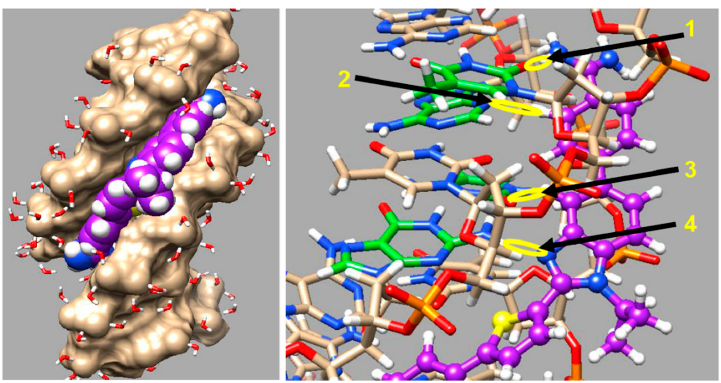
Figure 8. Molecular Dynamics (MD) model of DB2708 bound to an AAAGTTT site. A space filling model with DNA tan color is shown on the left where the isopropyl group and amidines of DB2708 (violet) are clearly seen. On the right side, the DNA bases are represented in tan-white-red-blue-orange (C − H − O − N − P) color scheme and DB2708 is violet -white-blue-yellow (C − H − N − S) color scheme. The detailed important interactions, H-bonds and other interactions described in the text,